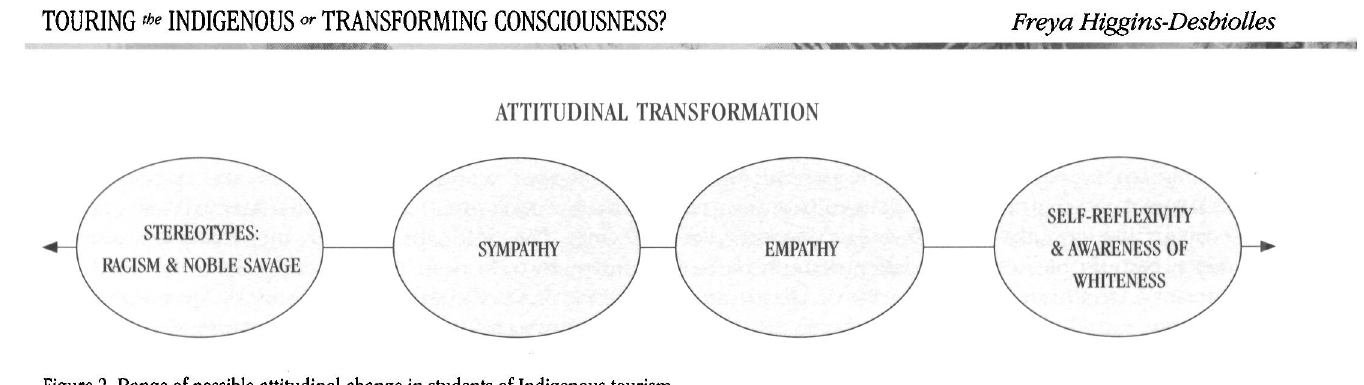
Figure 2. Range of possible attitudinal change in students of Indigenous tourism. have been